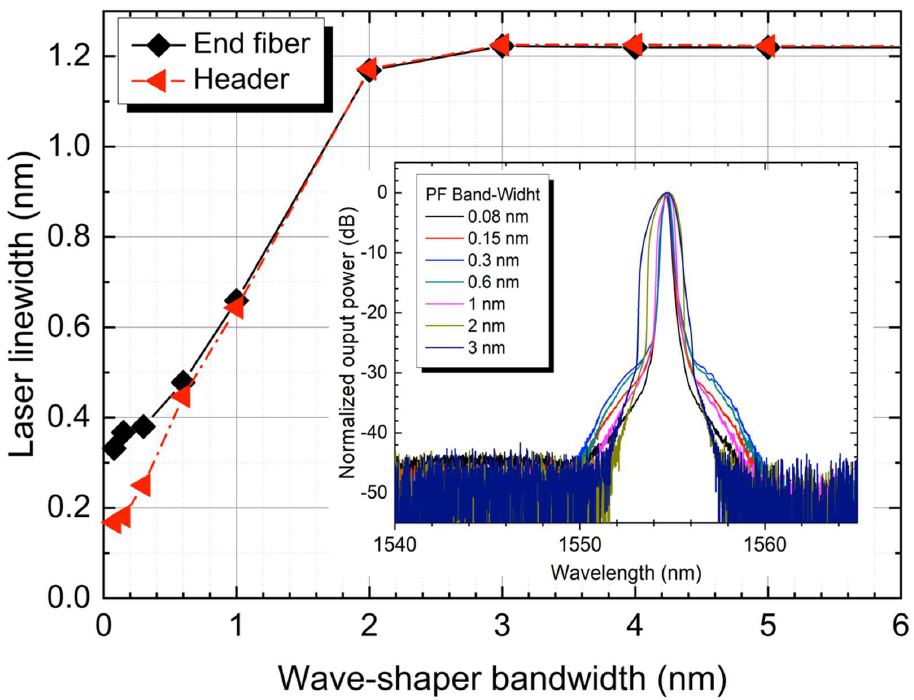
Figure 2. Laser linewidth evolution at end-fiber (black) and header (red), depending on the pro- grammable filter bandwidth selection. (Inset) Spectra at the end-fiber output measured at OSA (res- olution 0.01 nm) for different filter BWs.